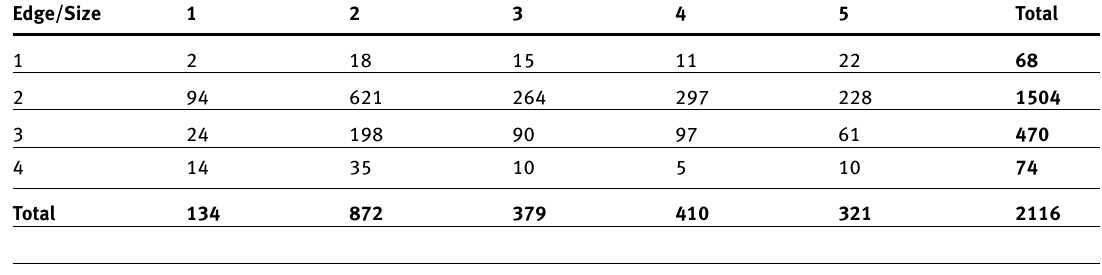
Table 4. Calculation of Kendall’s Tau C correlation, for ceramic sherds from all layers. N = total number of frequencies (sherds); k = smaller number of rows or columns (erosion classes – 4); P = sum of each cell multiplied by sum of all frequencies to below and right; Q = sum of each cell multiplied by sum of all frequencies to below and